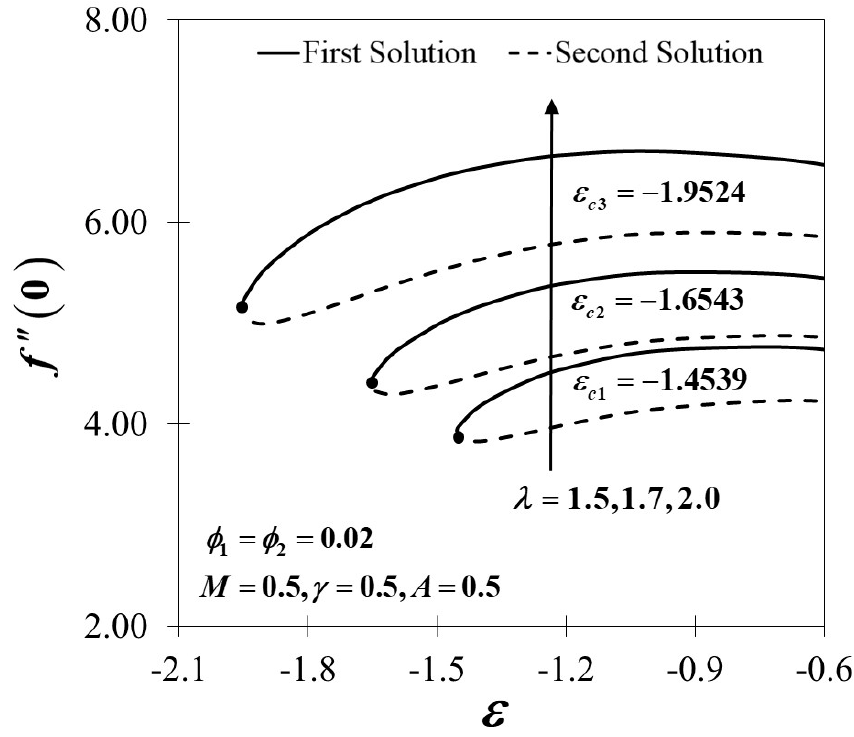
(cid:48)(cid:48) ( 0 ) for di ff erent values of λ . ′′ for different values of